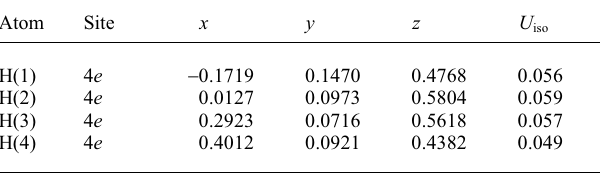
Table 2. Atomic coordinates and displacement parameters (in Å 2 )